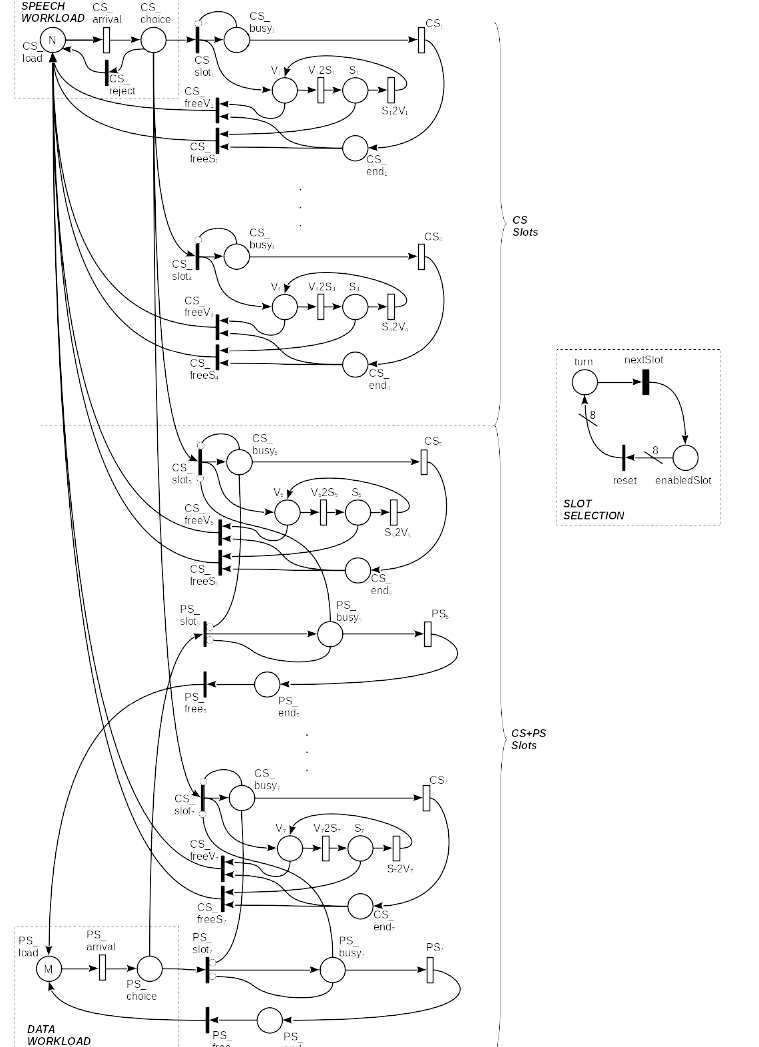
Figure 4. The PU model : primary users NMSPN model.